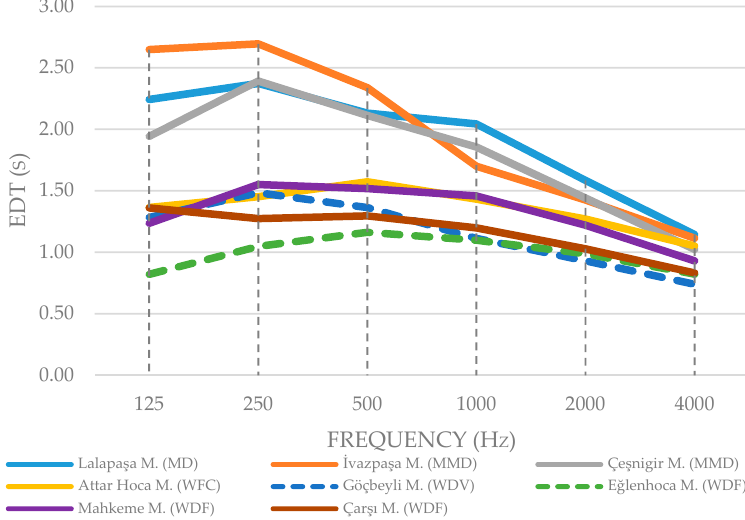
Figure 13. The average values of EDT measured in the eight mosques.